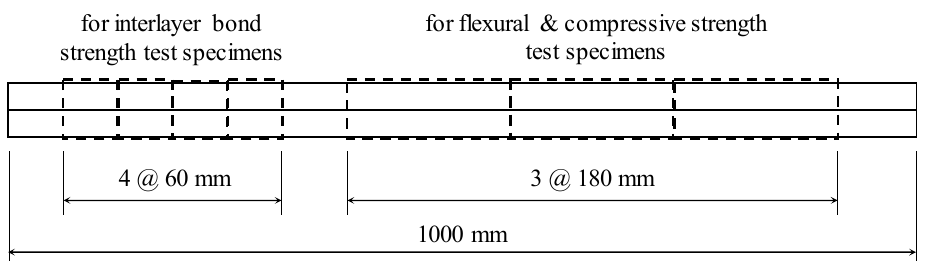
Figure 7. Cutting of additive parts before hardening.